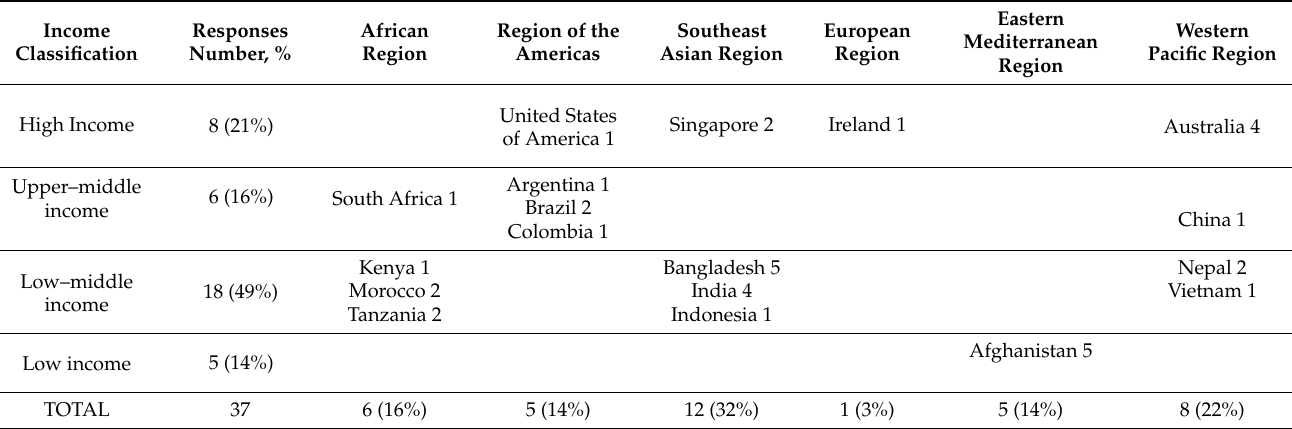
Table 1. Number of responses classified by income and